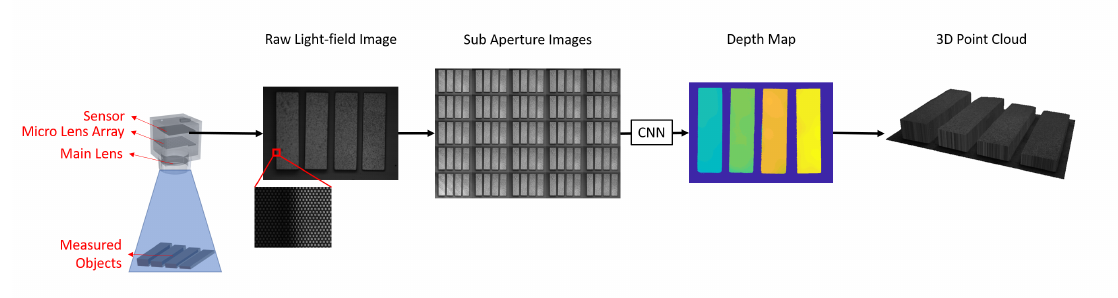
Figure 2. Our proposed measurement